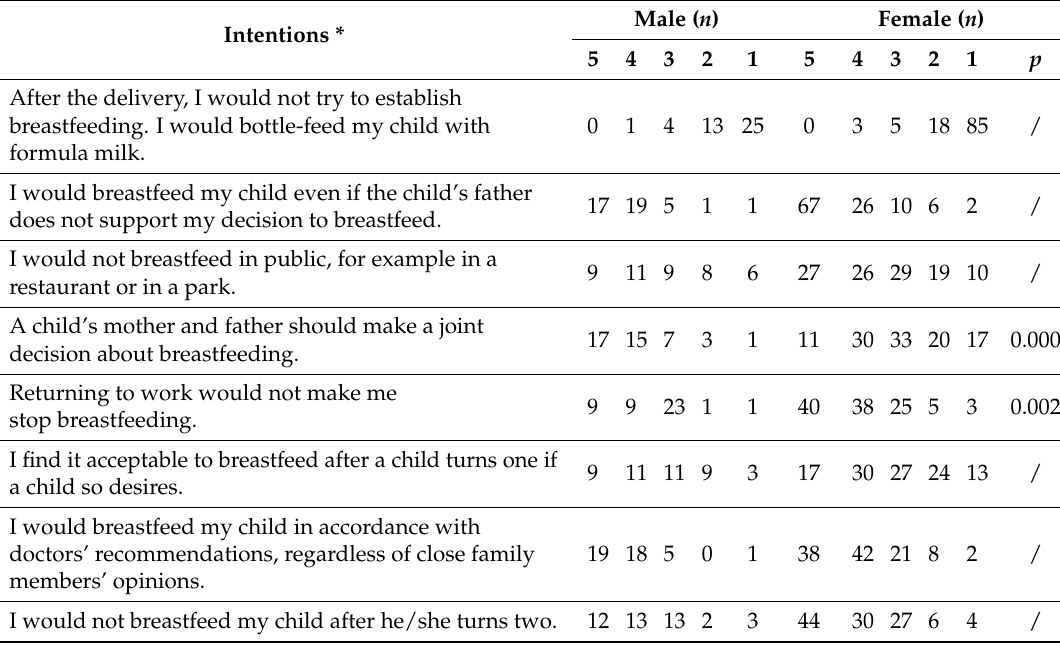
Table 2. The answers to the questions about breastfeeding